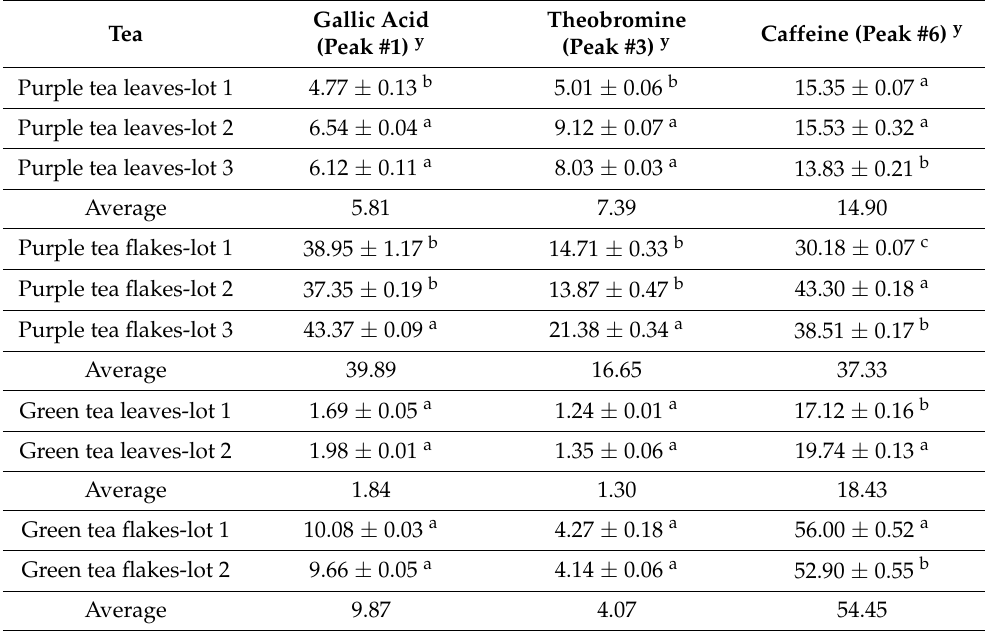
Table 6. Concentration of other bioactive compounds found in purple and green tea leaves and flakes (mean ± SD, mg/g) x